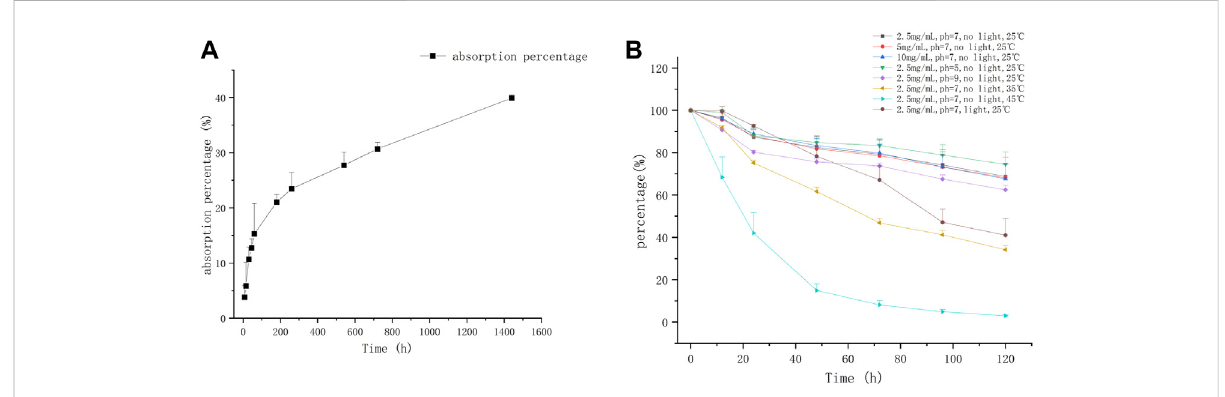
FIGURE 1 The adsorption and degradation curveofCEQ inenvironment (A) The kinetic adsorption curveof CEQ insoil; (B) The kinetic degradationcurve of CEQ in water).